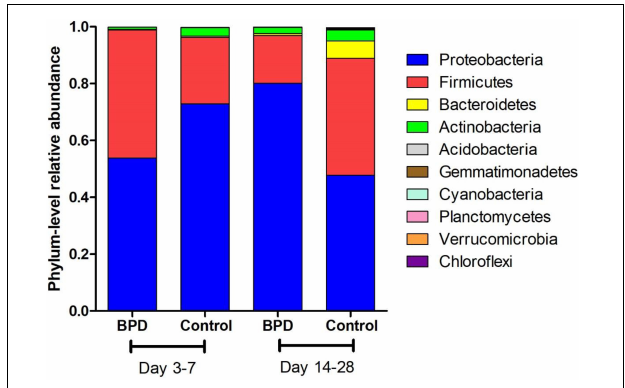
FIGURE 1 | The mean relative abundances of major microbiome (Top 10) of both groups at the phylum level on days 3–7 and 14–28.